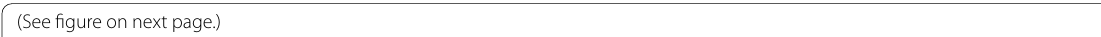
Fig. 4 Variation estimates by runs and analysts using human serum sample S / N ratio values, excluding high CV samples, voided samples, and outliers. Box and whisker plot of 25th and 75th percentiles, median, minimum, and maximum is presented. Analyst 1 analyst 2 (Q3 1.5 interquartile). a Estimation of variation between runs. b Estimation of variation between analysts. c Estimation of variation = + × between analysts and runs. CV, coefficient of variation; DF Den, denominator degree of freedom; DF Num, numerator degree of freedom; ECL, electrochemiluminescence; Prob, probability S / N , signal